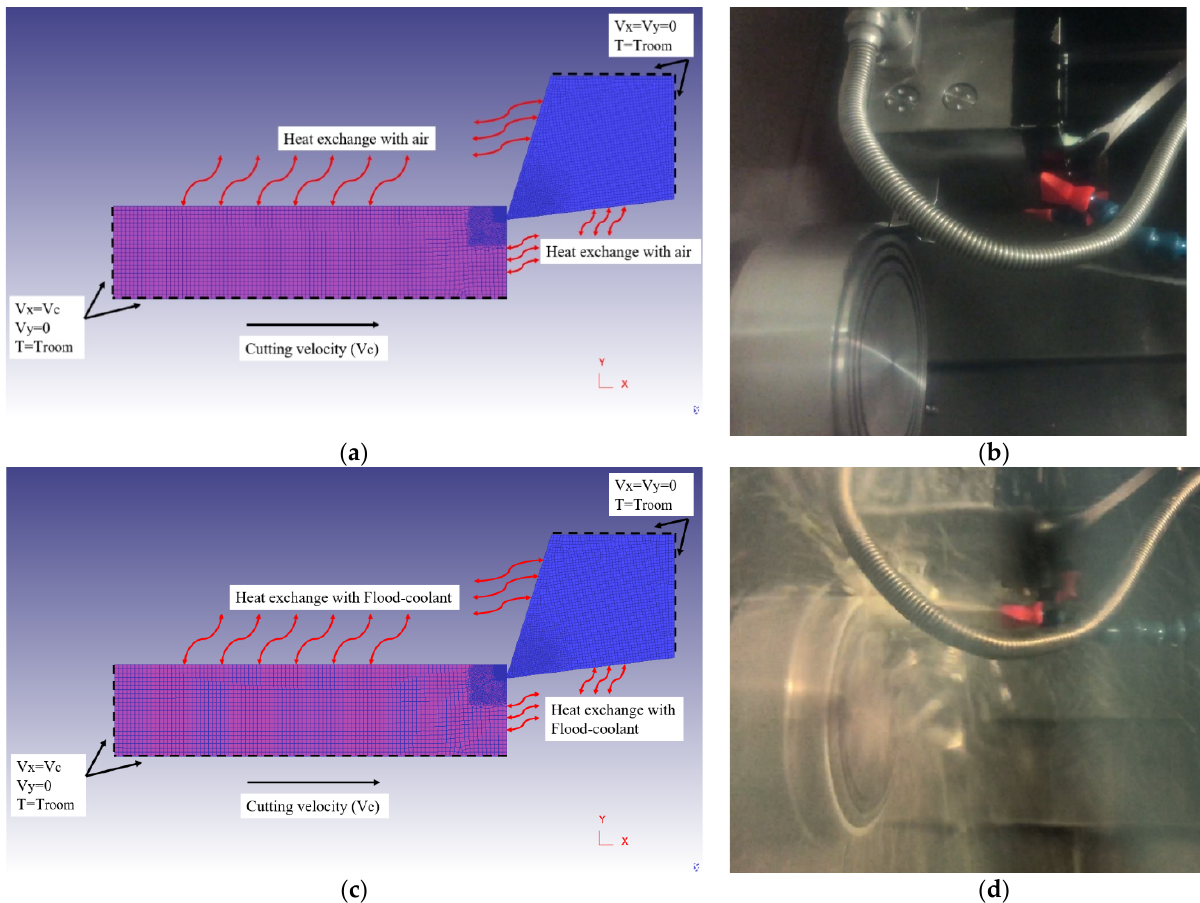
Figure 12. Thermal and mechanical boundary conditions in the cutting process of ( a ) dry-FE model, ( b ) dry-Exp. test, ( c ) flood coolant-FE model, ( d ) flood coolant-Exp. test.